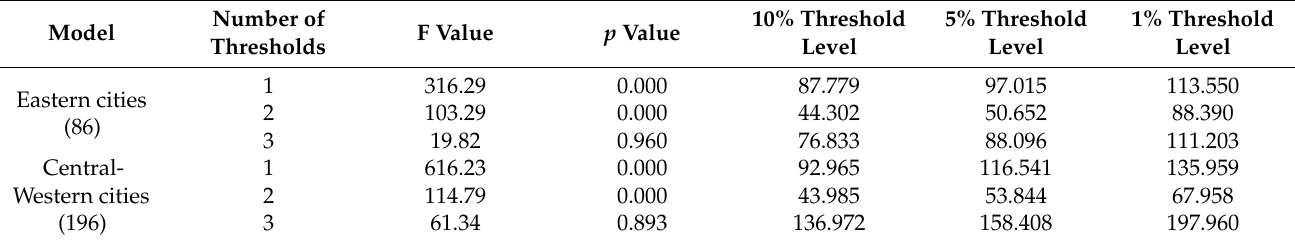
Table 5. Test of the threshold effect.